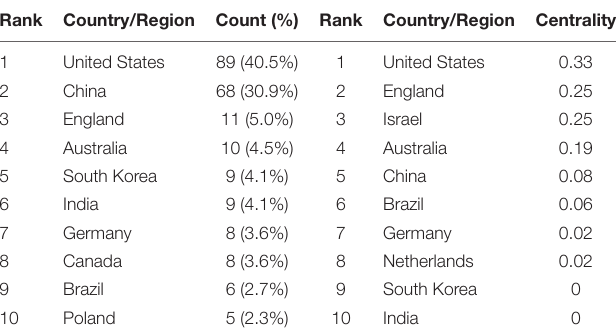
TABLE 2 | Top 10 countries/regions in terms of publications and